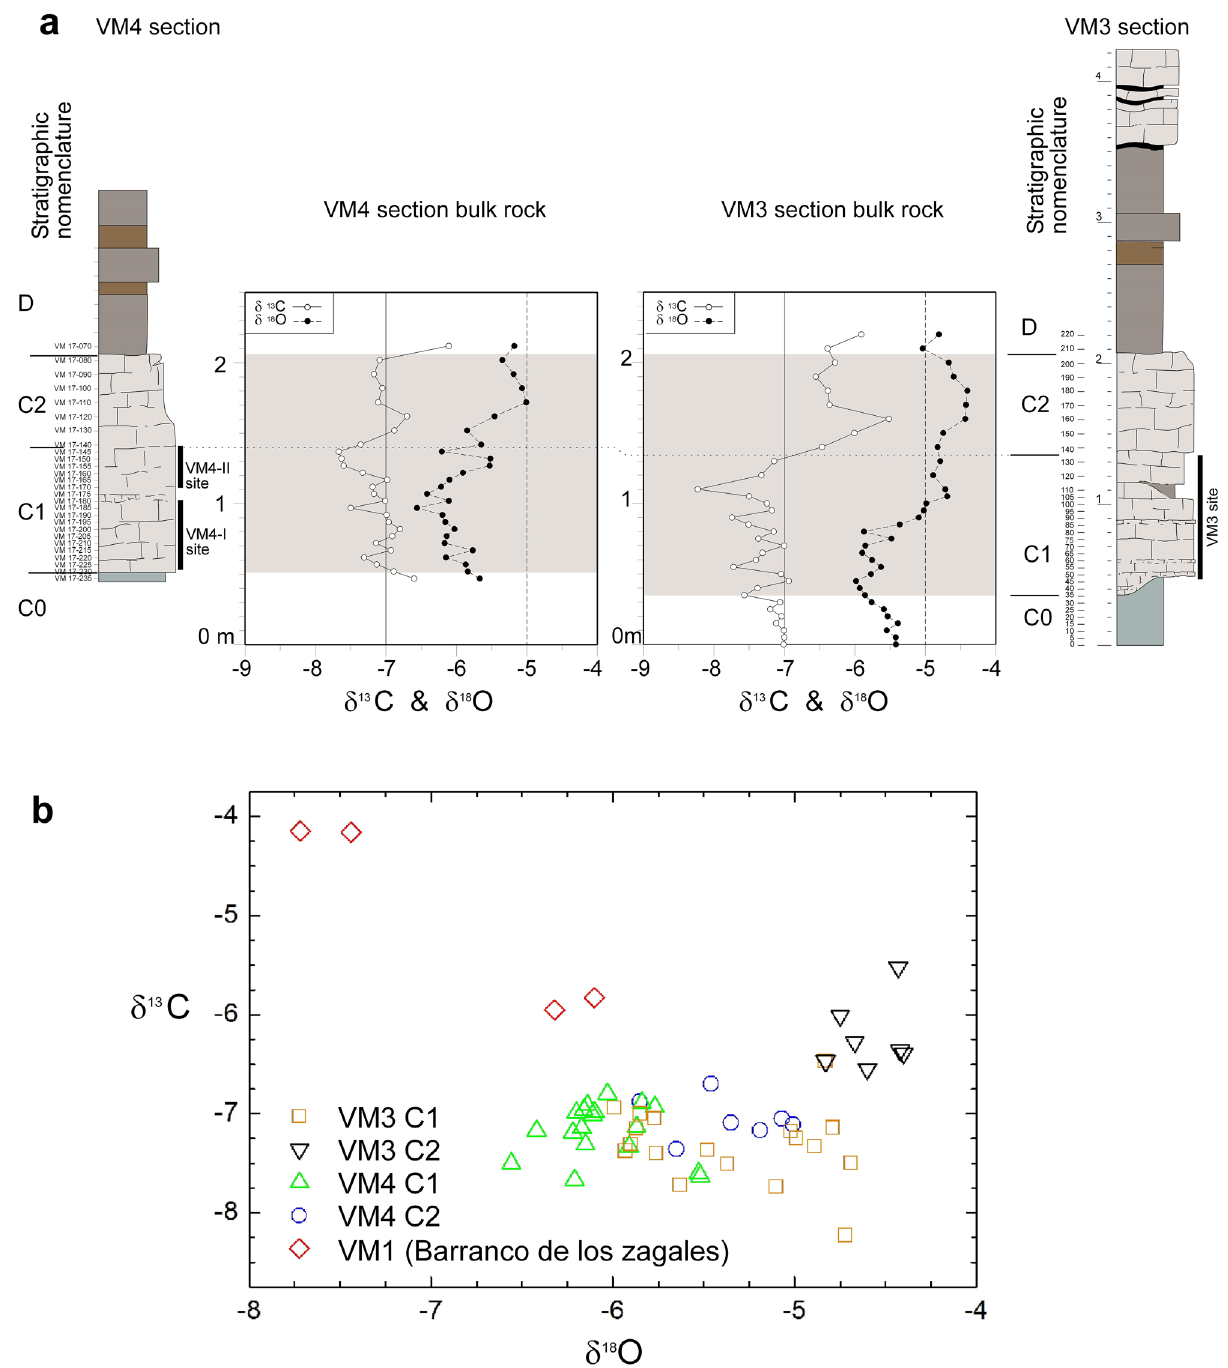
Figure 6. ( a ) Bulk-rock oxygen and carbon curves from sections VM3 and VM4. ( b ) Stable isotope cross-plots for sections VM3 and VM4. See values in STab.